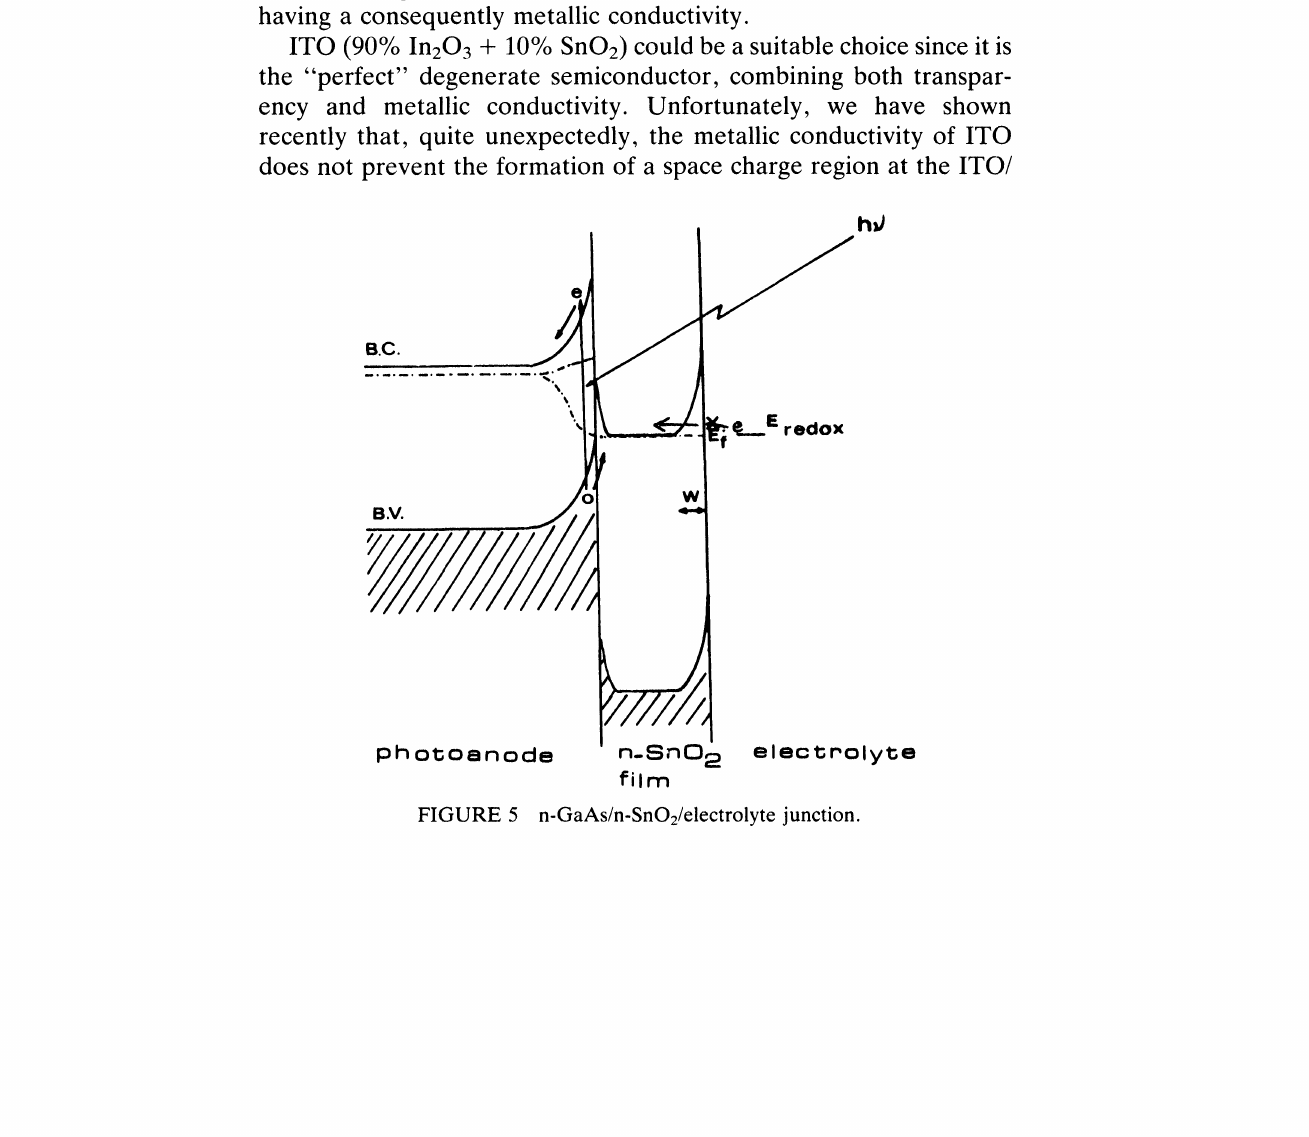
FIGURE 5 n-GaAs/n-SnO2/electrolyte